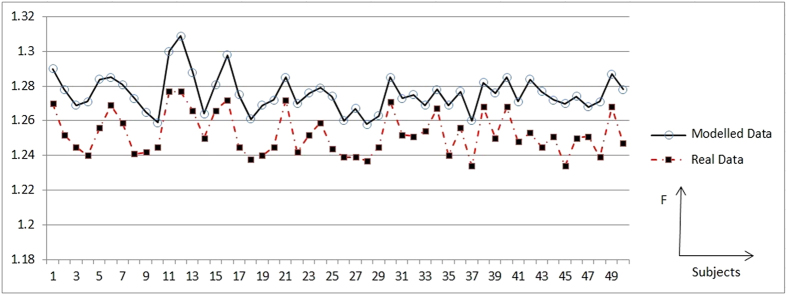
Means of Fractal dimension variation for real and modelled DNA walks in case of different subjects.